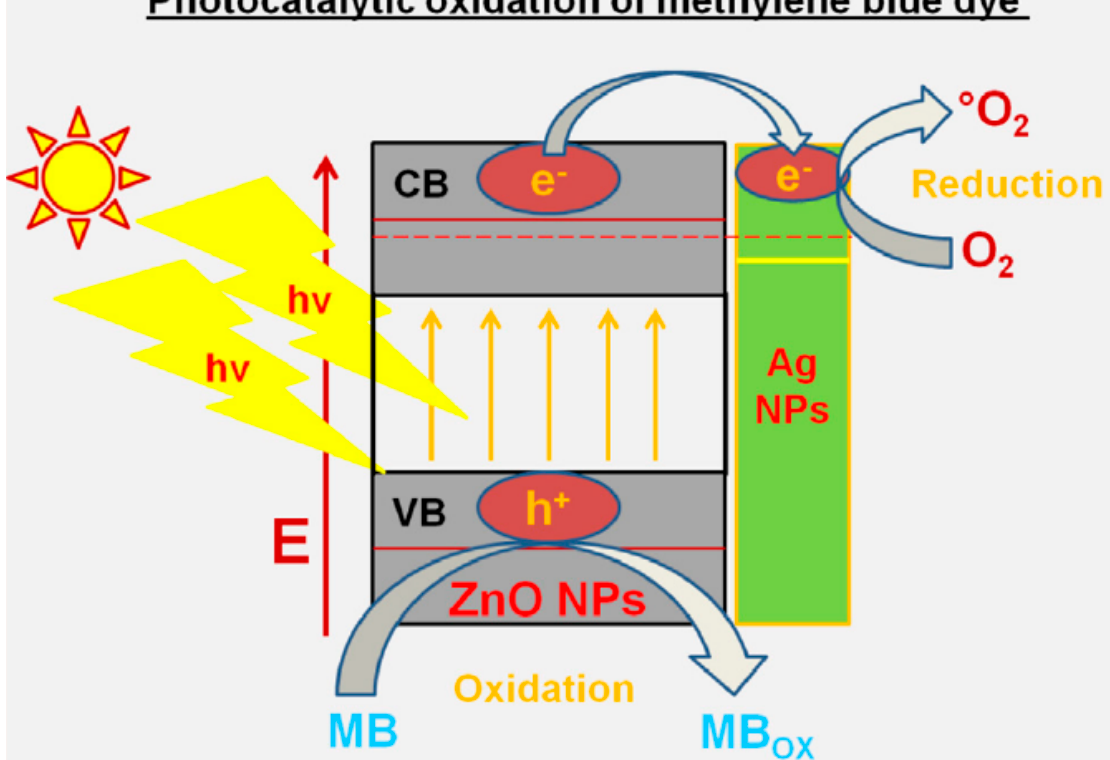
Figure 9. Diagrammatic portrayal of photocatalytic oxidation of the methylene blue (MB) dye at the aminosilicate sol–gel supported silver nanoparticles. Reproduced from reference [123], with permission from Elsevier, 2018.